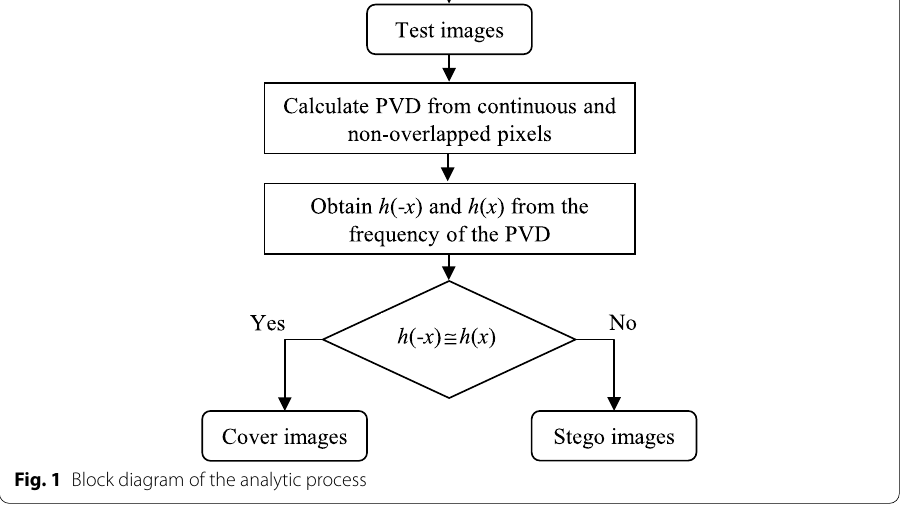
Fig. 1 Block diagram of the analytic process